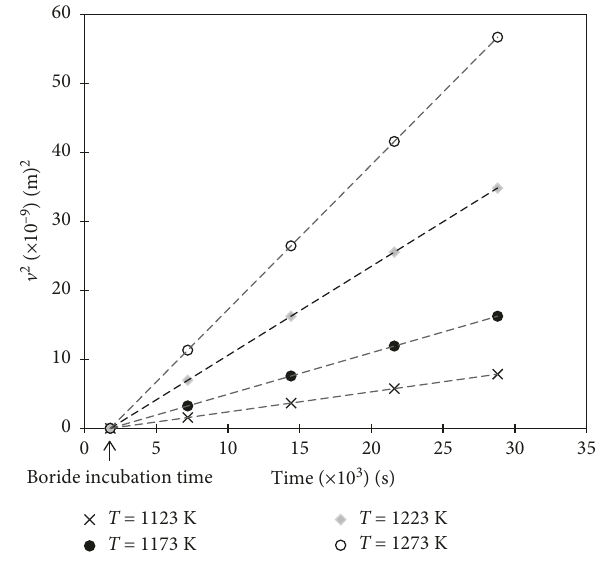
Figure 7: Averaged squares of the boride layers ( v 2 ) vs. boriding time ( t ) at increasing